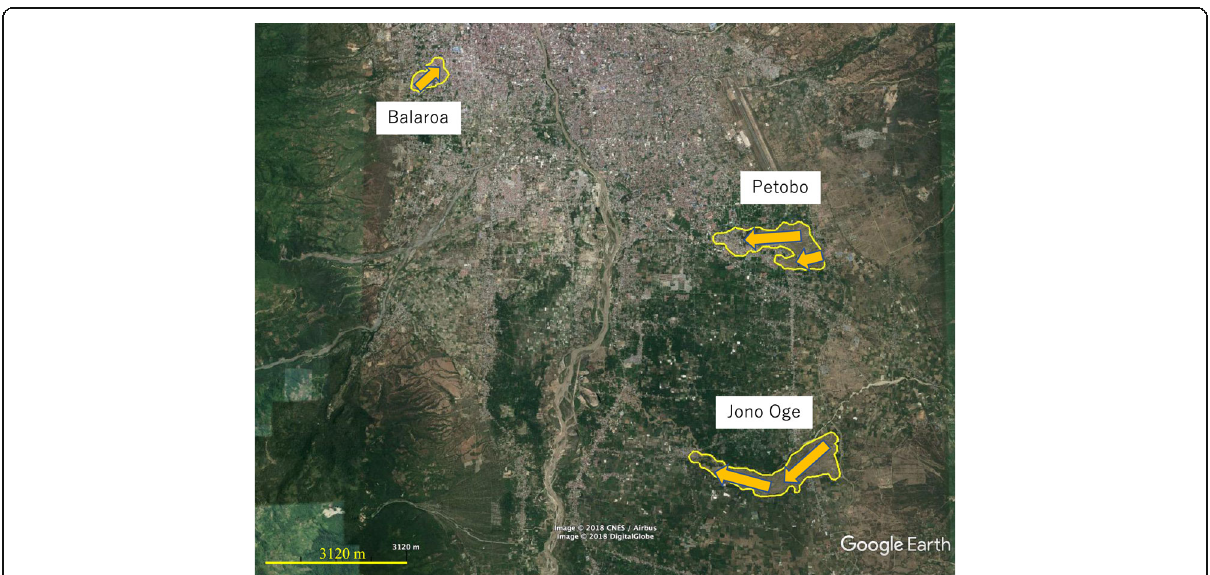
Fig. 8 Locations of large ground flow of Balaroa and Petobo districts in Palu city and Jono Oge village and the direction of the ground flow